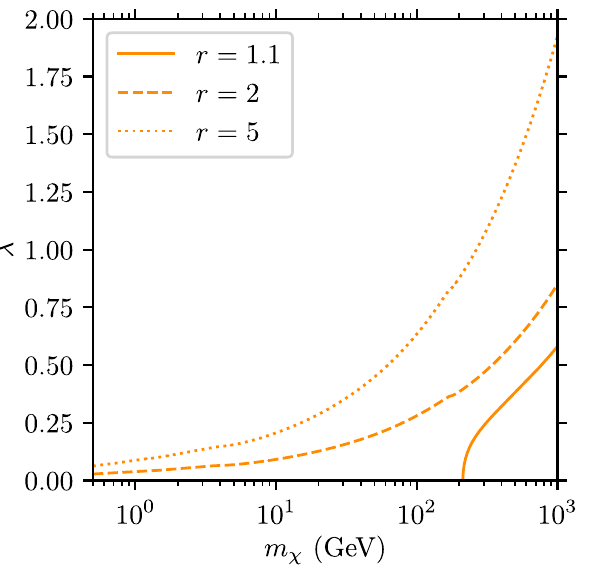
Fig. 6 K factor for σ SI p in the t -channel model of Eq. (2) for a fixed mediatormass M med = 2 TeV,togetherwithbandsindicatingtherenor- malizationscaleuncertainty.Notethatthe K factorof σ SD n isnotshown, as it is numerically very similar to the one for σ SI p , with differences of at most